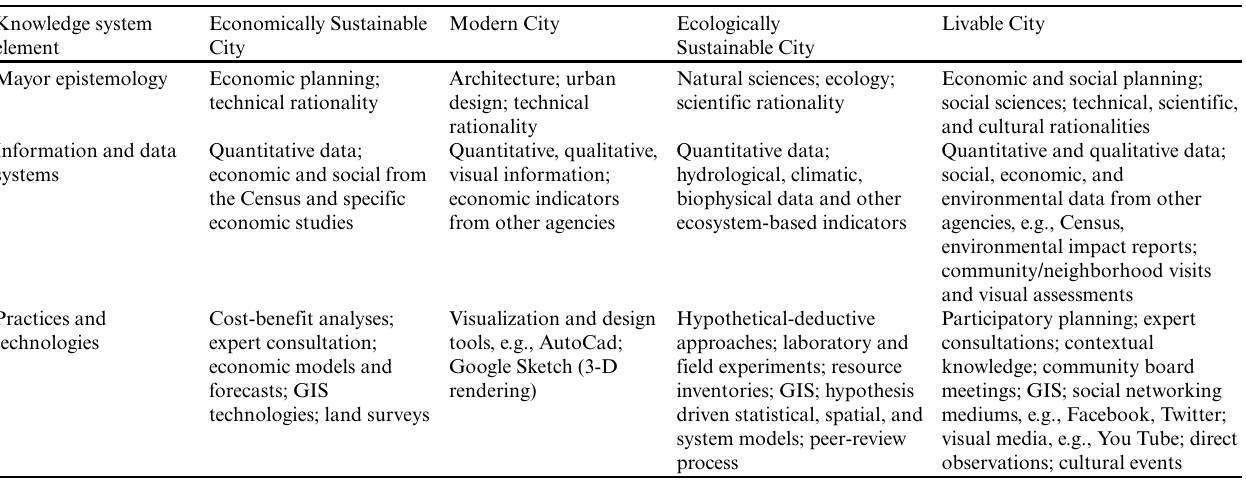
Table 2 . Summary of the knowledge systems supporting different visions in San